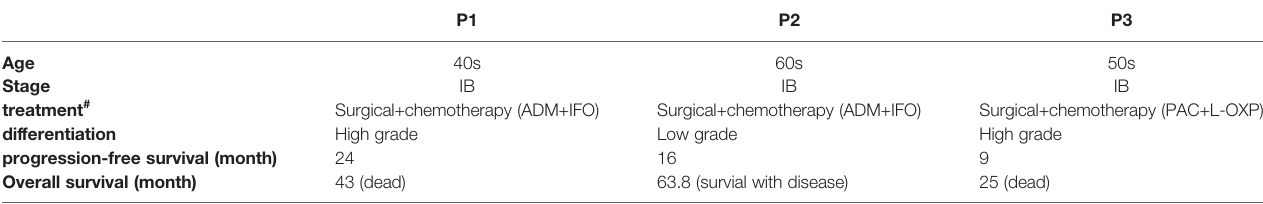
TABLE 1 | The characteristics of the patients and the tumor tissue was obtained during the second cytoreductive surgery.